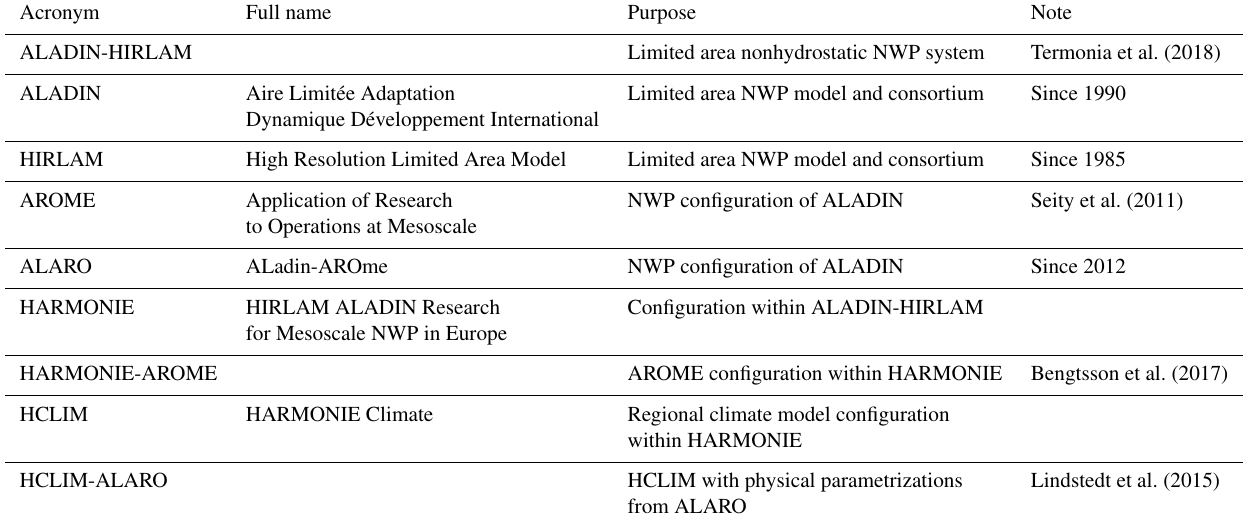
Table 1. Glossary of the ALADIN-HIRLAM system.